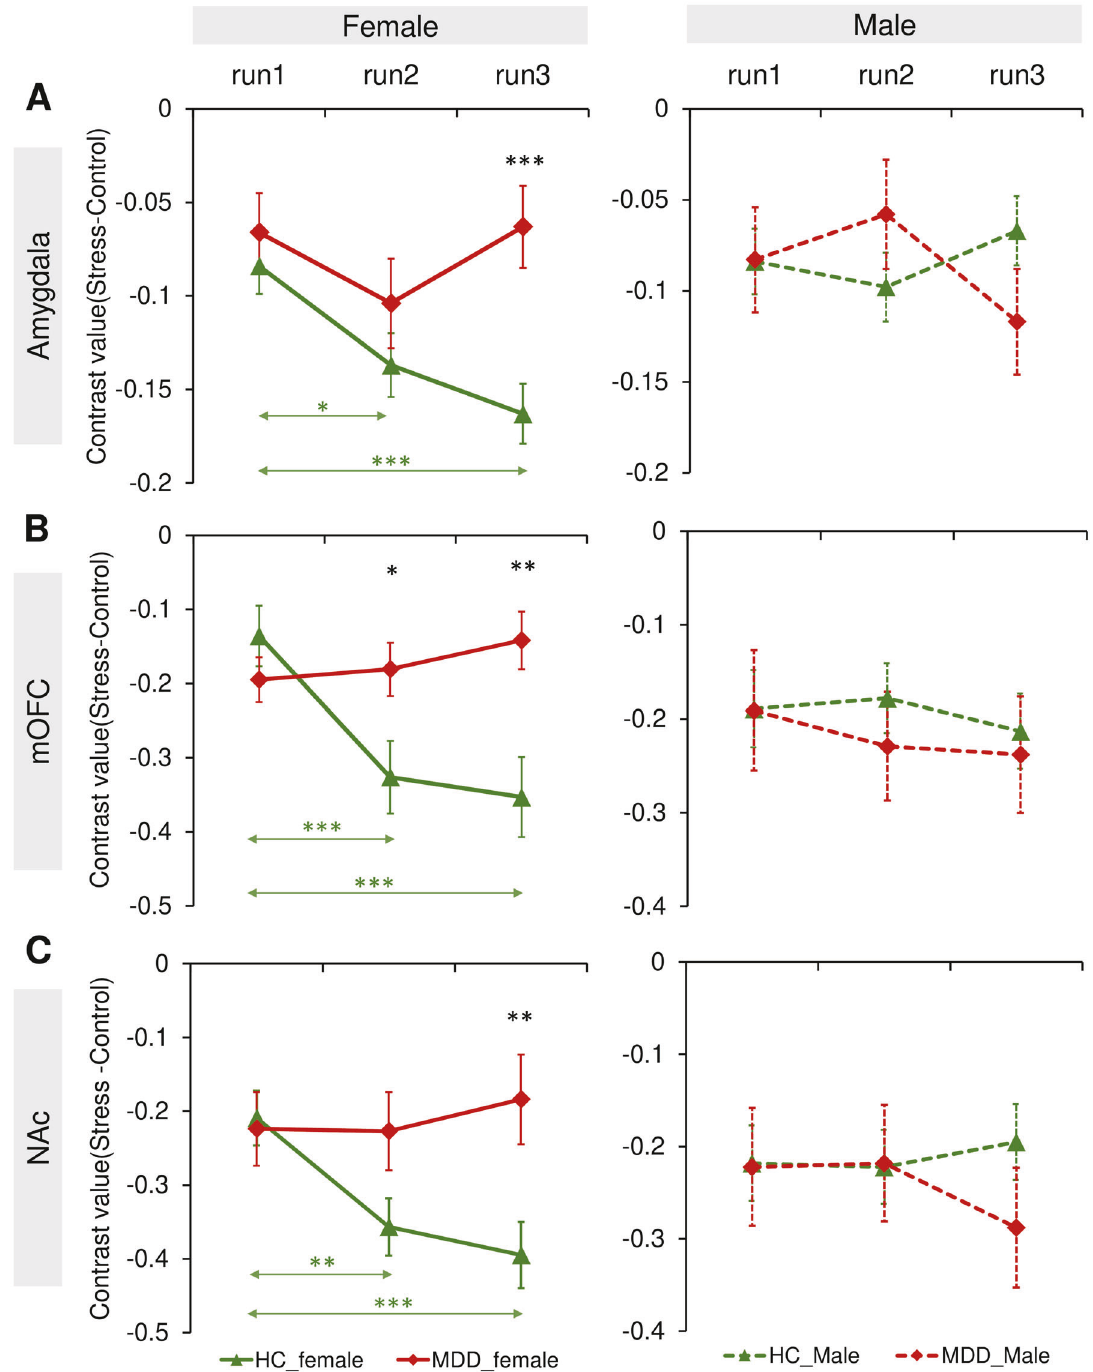
Fig. 3 Neural stress responses in different runs. A signi fi cant Time × Diagnosis × Sex interaction effect emerged in the ( A ) amygdala, ( B ) medial orbitofrontal cortex, and ( C ) nucleus accumbens. Estimated-mean are plotted, and error bar represent SE. HC healthy controls, MDD major depressive disorder. * p Bonferroni < 0.05, ** p Bonferroni < 0.01, *** p Bonferroni <